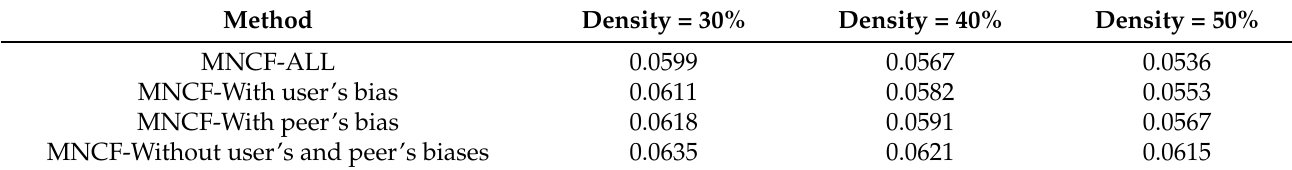
Table 6. Performance of RMSE with Different Context (MaxBlockBack = 100, MaxRTT =